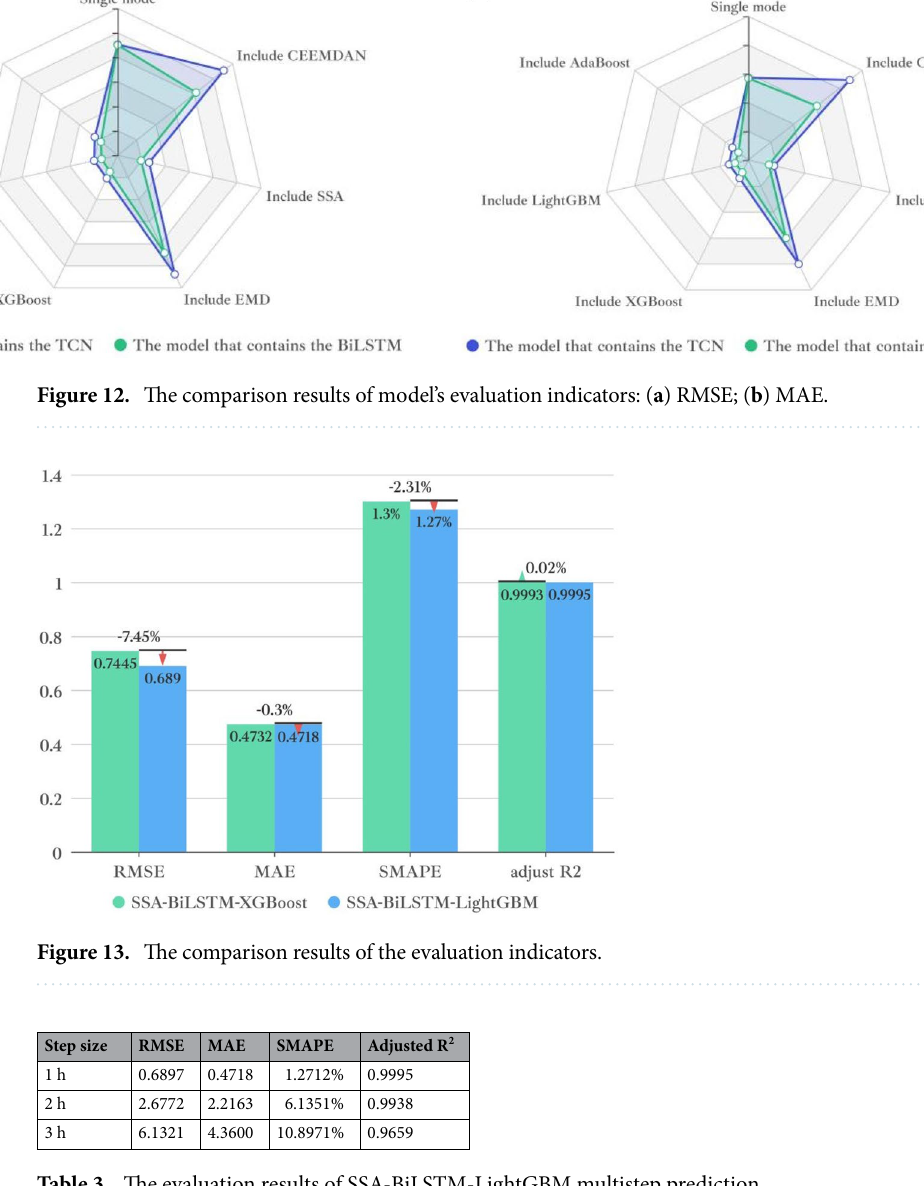
Table 3. The evaluation results of SSA-BiLSTM-LightGBM multistep